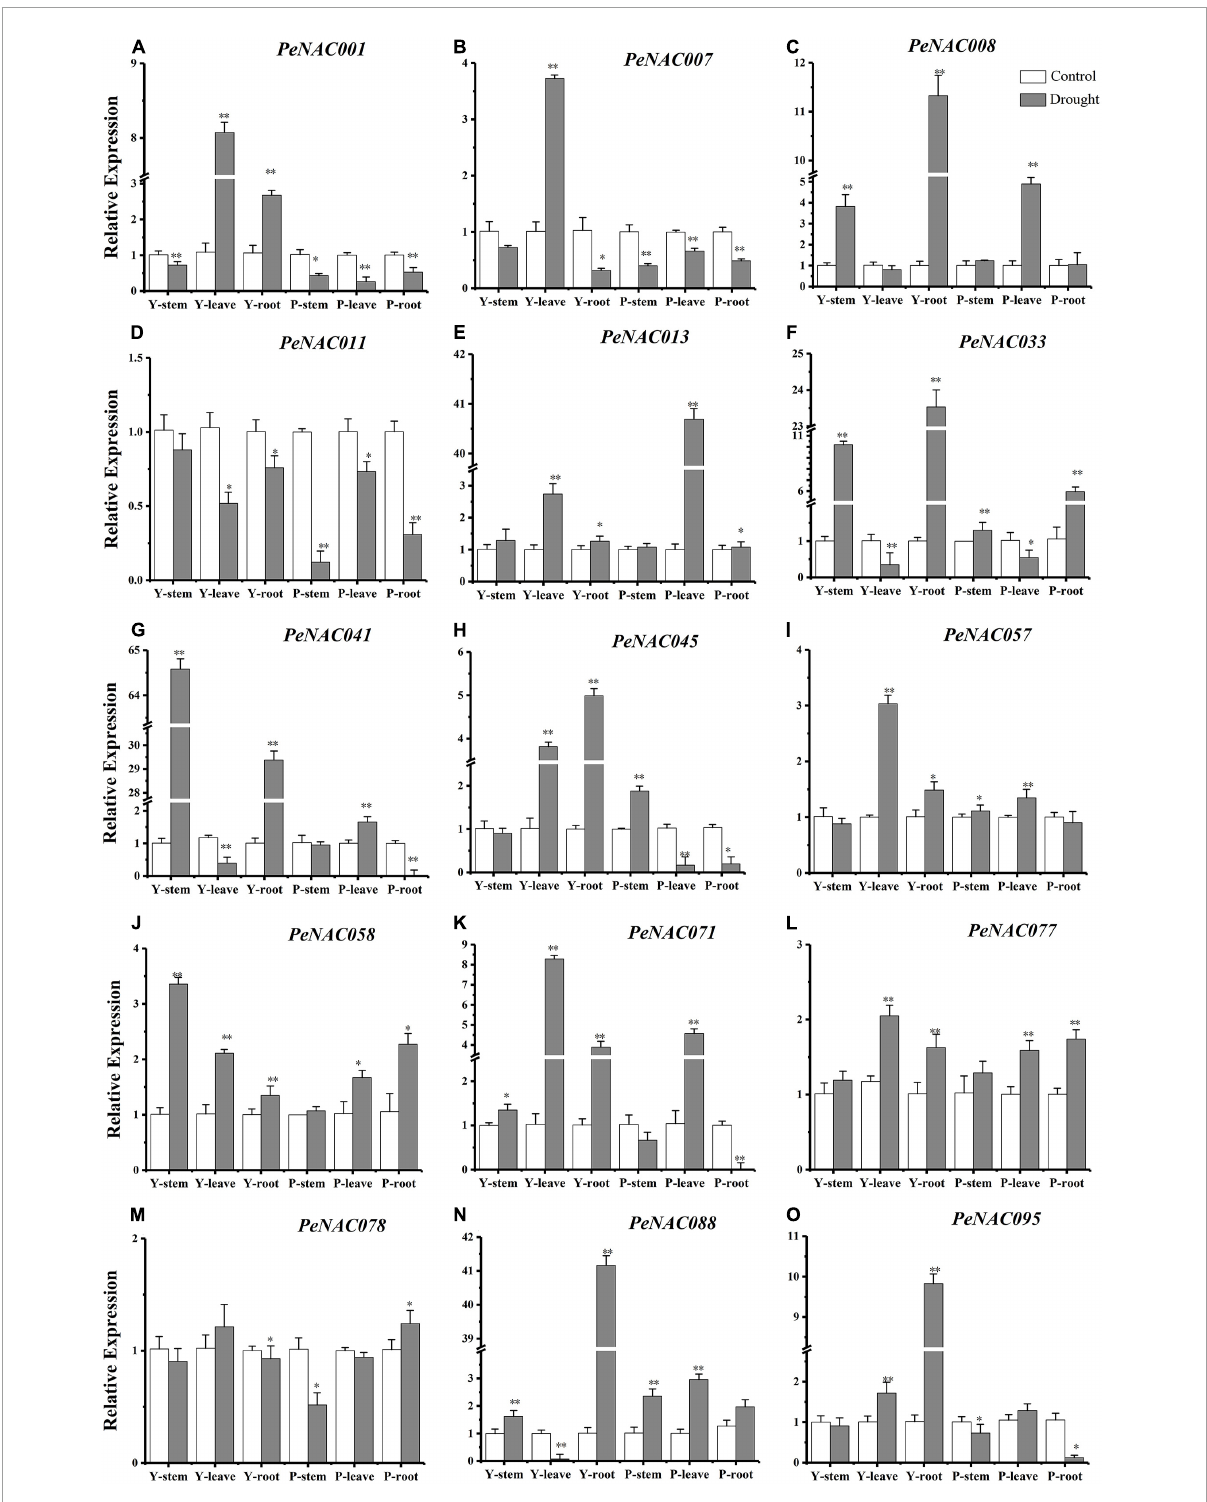
FIGURE11 The relative expressions of PeNAC genes in the stem, root, and leave tissues of yellow and purple passion fruits under drought stress and control conditions (A–O) . The relative gene expression levels were calculated using the 2 − (cid:49)(cid:49) Ct . Vertical bars represent means ± SD ( n = 3). The * and ** show significance at p ≤ 0.05 and p ≤ 0.01. Y represents the yellow passion fruit; P represents the purple passion fruit; and dpi represents the days